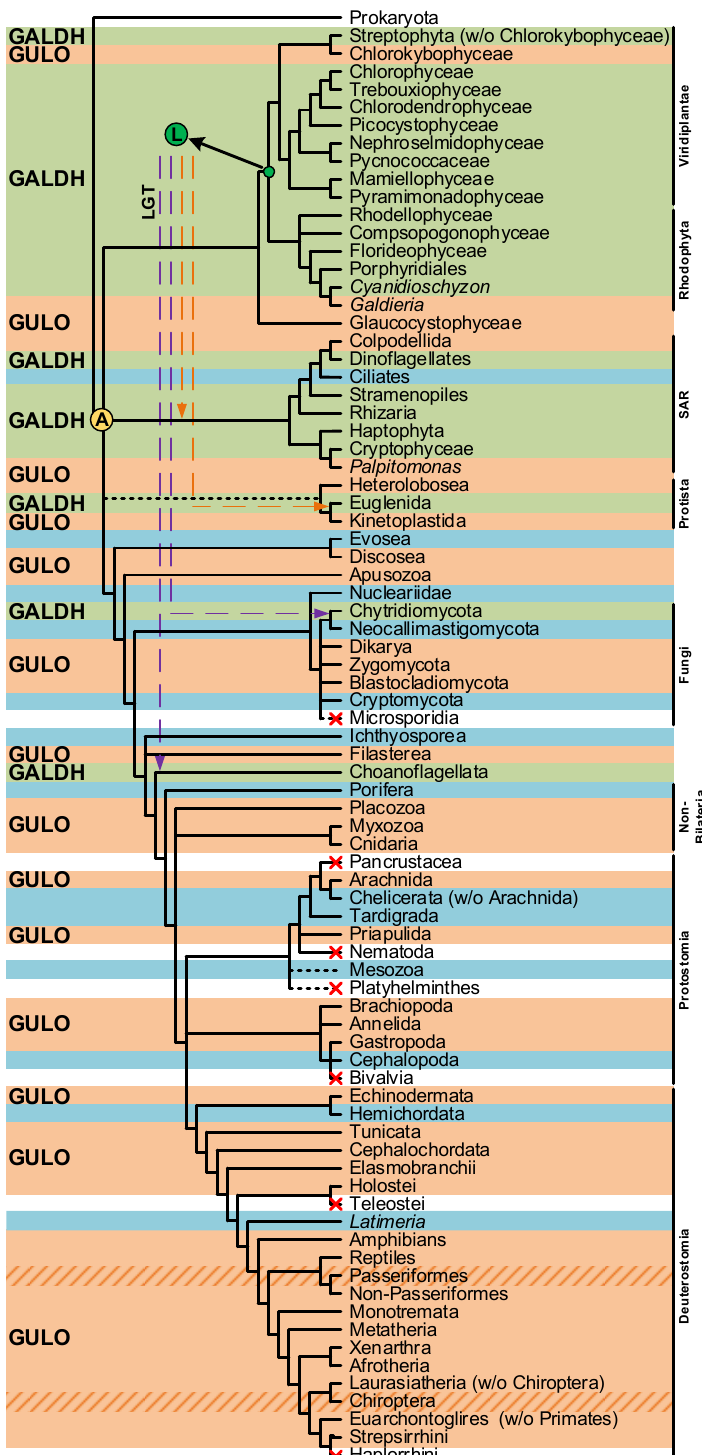
Figure 3. Presence/absence pattern of the GULO / GALDH lineages in eukaryotes. The taxonomic groups where the GULO lineage is present are highlighted by an orange background, while those where the GALDH lineage is present are highlighted by a green background. Independent GULO loss events within specific vertebrate groups are represented by stripe patterns. The blue background highlights uncertainty regarding either gene lineage presence/absence. These cases represent groups where both gene lineages could not be found in less than three species, or groups where the